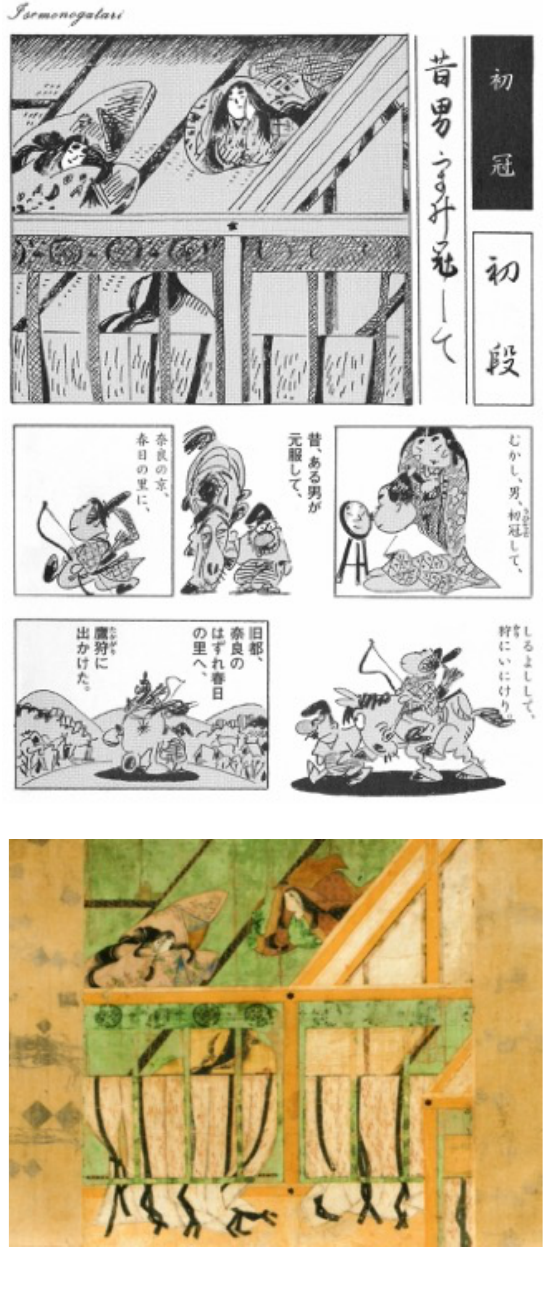
Figure 10. Kubo version Ise stories illustrated scroll , illustration of episode 1. Thirteenth century. Handscroll. Ink, gold, and color on paper. 27.0 x 24.9